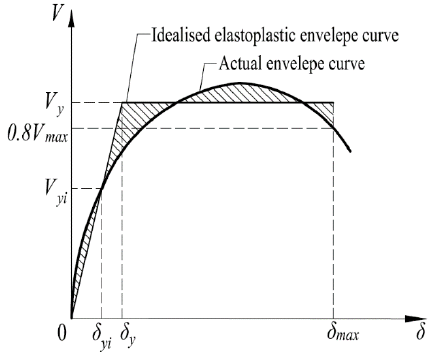
Figure 12. Definition of the idealized elastoplastic envelope curve.